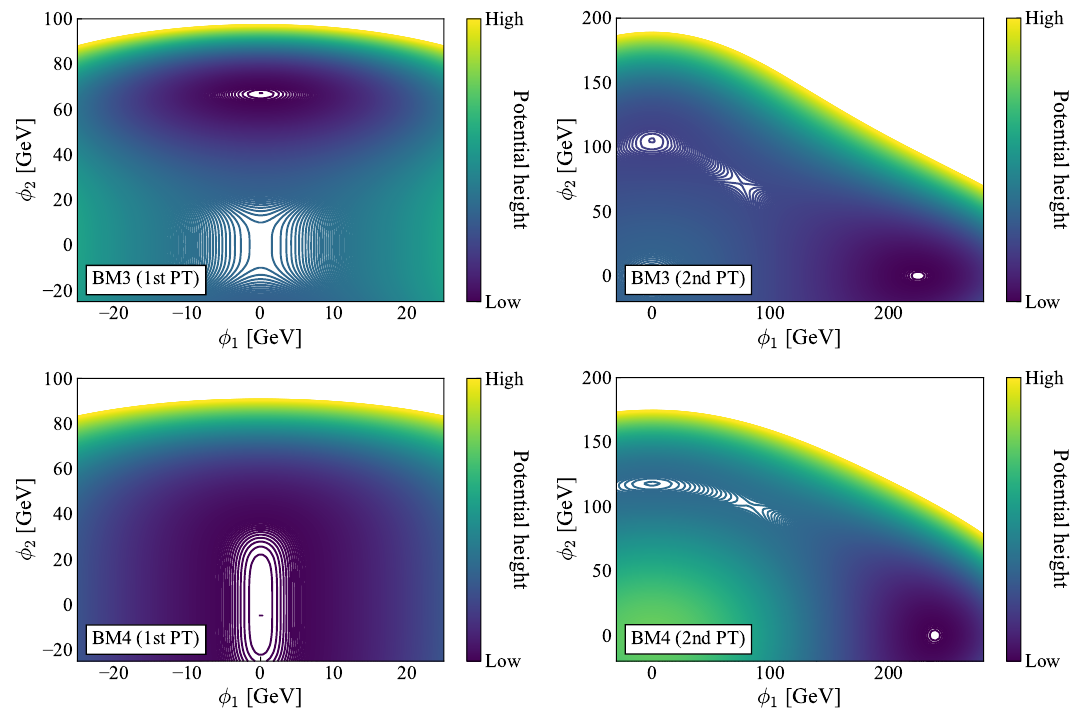
Figure 4 . Contours of the finite temperature effective potential for BM3 (top) and BM4 (bottom) at the nucleation temperatures, The nucleation temperatures are determined as T n 1 = 148 GeV (top left) and T n 2 = 86 GeV (top right) for BM3 while T n 1 = 184 GeV (bottom left) and T n 2 = 66 GeV bottom (right) for BM4. The first PTs in the left panels occur from the origin to (0 , φ 2 ( T n 1 )) along the φ 2 axis, whereas the second PTs in the right panels occur from (0 , φ 2 ( T n 2 )) to the EW